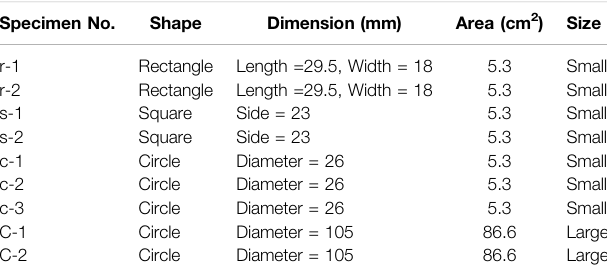
TABLE 1 | General speci fi cations of the half cells. Specimen No.